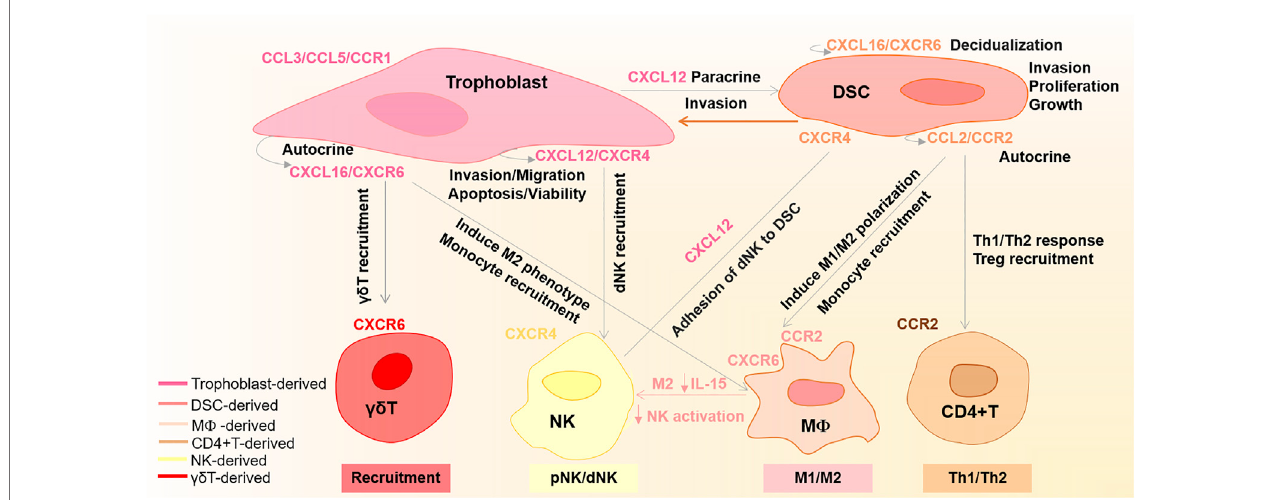
FIGURE 1 | Regulation of main chemokines and chemokine receptors at the maternal – fetal interface. CXCL16 binding to CXCR6 promotes trophoblast invasion and proliferation, as well as endometrium decidualization in an autocrine and paracrine manner, respectively. CXCL16 is also involved in recruiting γδ T cells and monocytes. Moreover, CXCL16/CXCR6 can induce M2 phenotype macrophages and decrease their IL-15 levels, which in turn induce the inactivation of NK cells. Trophoblast-derived CXCL12 with CXCR4 not only promotes trophoblast cell migration, invasion, and apoptosis via an autocrine manner but also enhances DSC invasion by upregulating the CXCR4 expression in a paracrine manner. Additionally, the trophoblast-derived CXCL12 also participates in NK cell recruitment and enhances the adhesive abilities of dNK cells to DSCs. CCL2/CCR2 enhances DSC invasion, proliferation, and growth in an autocrine manner. Moreover, CCL2/ CCR2 also shows roles in M1/M2 phenotype polarization, monocyte recruitment, Treg recruitment, and Th1/Th2 immune response. CCL3/CCL5/CCR1 plays an essential function in trophoblast invasion.